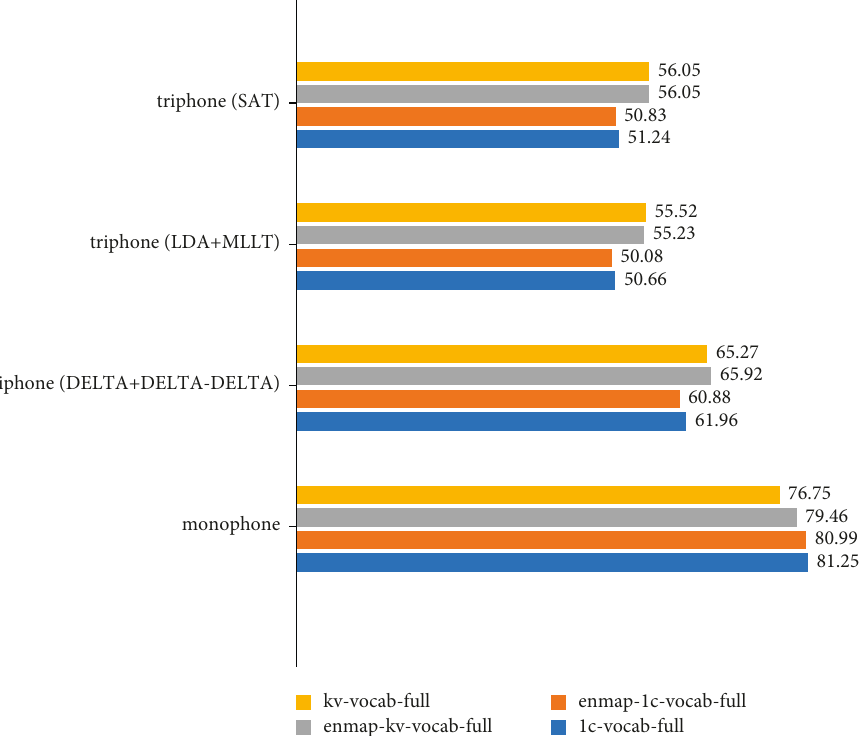
Figure 10: The %WER comparison for different GMM-HMM models using 46,550 validated utterances. Table 13: The performance of the acoustic models using 46,550 unvalidated utterances. Lexicon